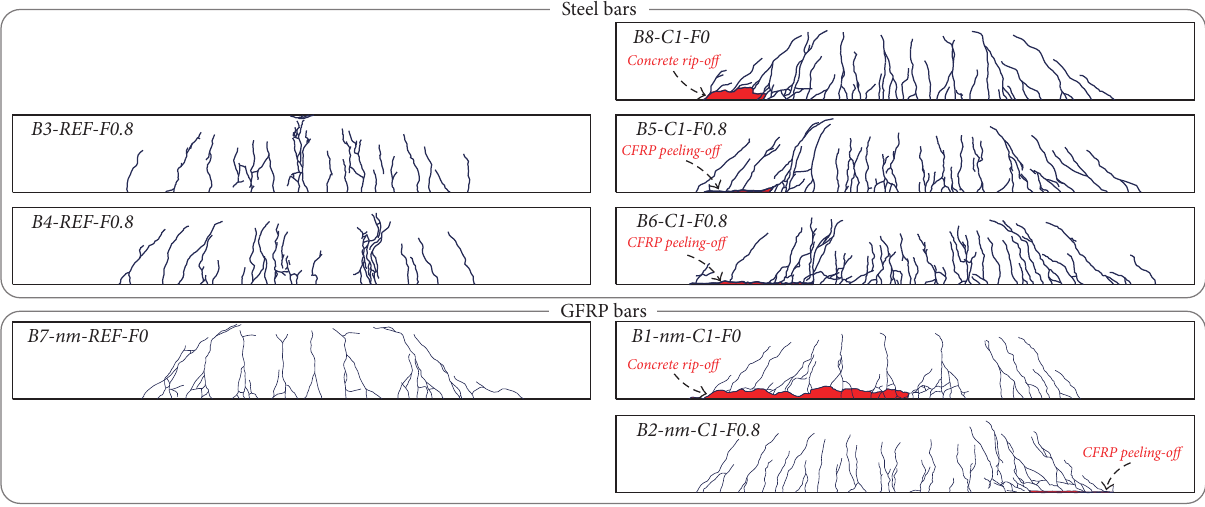
Figure 10: Final crack pattern of the